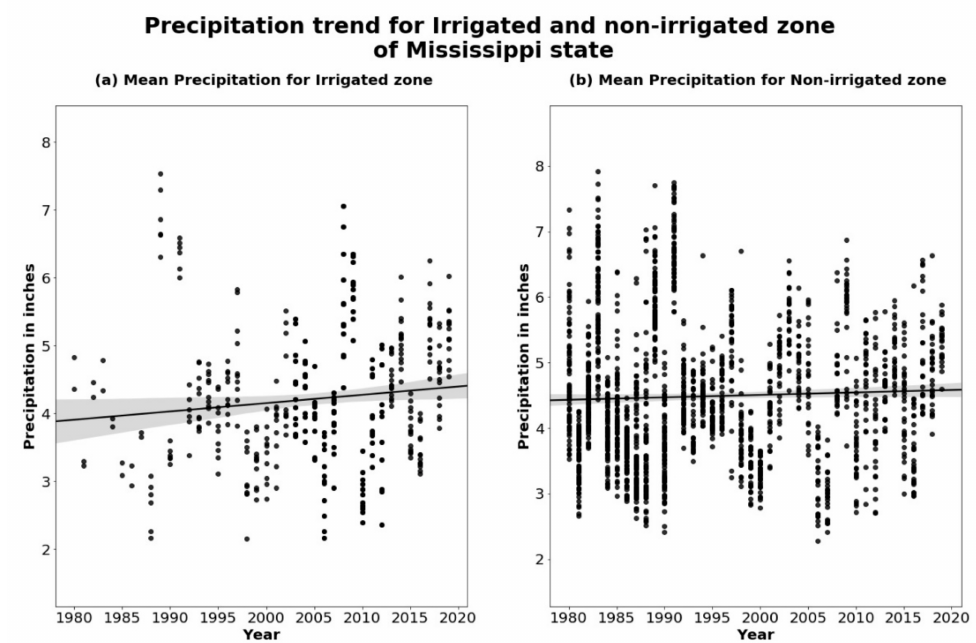
Figure 5. Trends for seasonal precipitation change for ( a ) irrigated zones and ( b ) non–irrigated zones of the Mississippi State from 1980 to